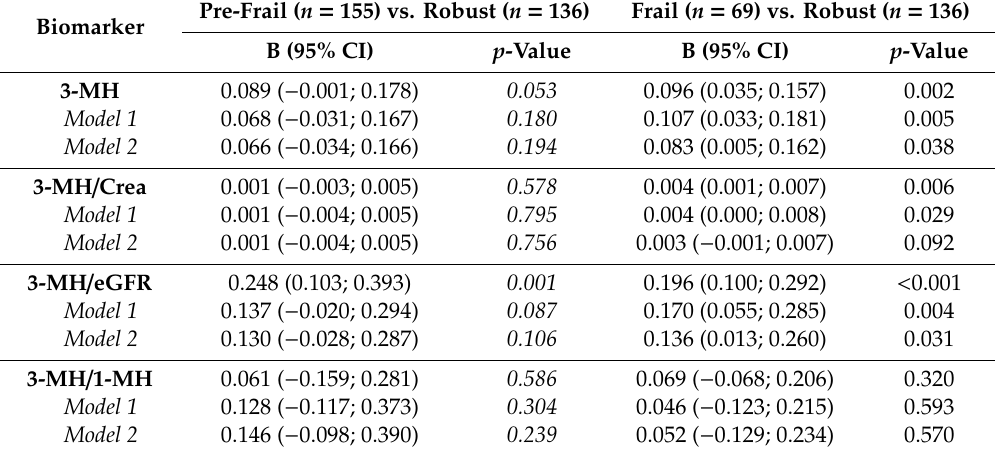
Table 3. Associations of plasma 3-MH concentrations and, 3-MH / Crea, 3-MH / eGFR and 3-MH / 1-MH ratios with pre-frailty and frailty (robust as reference group) assessed by multiple linear regression